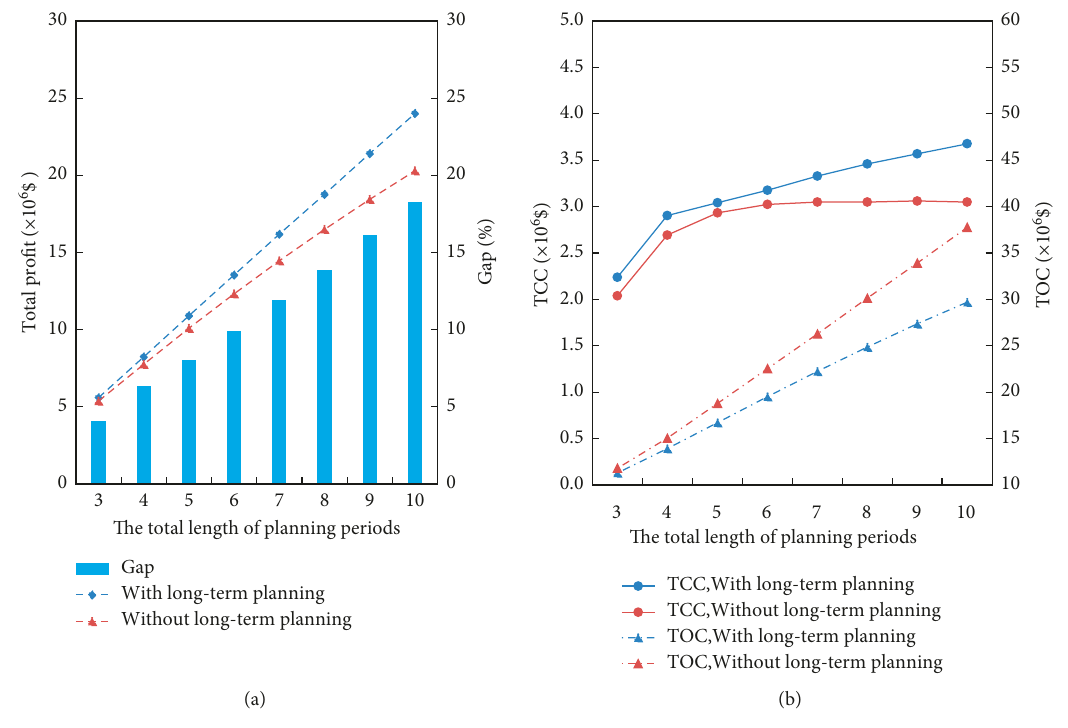
Figure 10: System performance with and without long-term planning.